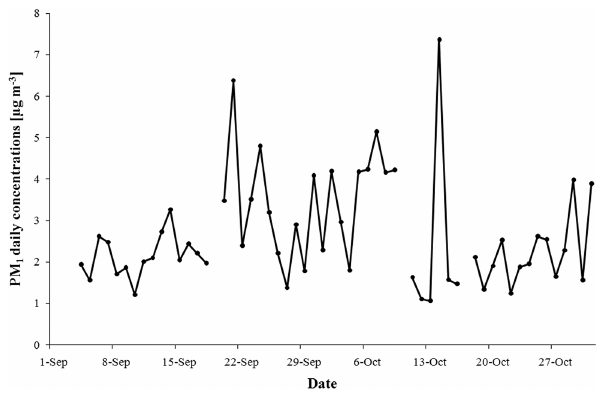
Figure 4. Temporal pattern of the PM 1 daily concentrations mea- sured at Viggiano town from 1 September to 31 October